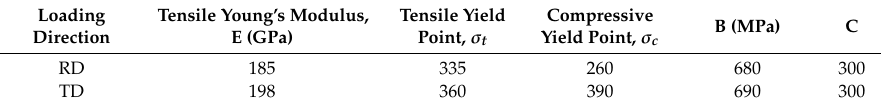
( b ) Figure 7. Comparison of bending moment–curvature diagrams for pure bending in the ( a ) rolling direction and ( b ) transverse direction. The variation of neutral surface shift versus the curvature change is shown in Figure 8 for pure bending in RD and TD. As it can be seen, the natural surface shift is zero at the beginning due to the elastic bending. However, by increasing the bending curvature, elastoplastic bending occurs and the natural surface shift increases. Moreover, the neutral surface shifts with a high rate initially and slows down as the plastic deformation governs the bending behaviours. In addition, the neutral surface shifts to the inner and outer radius of bending under bending in TD and RD, respectively. The neutral